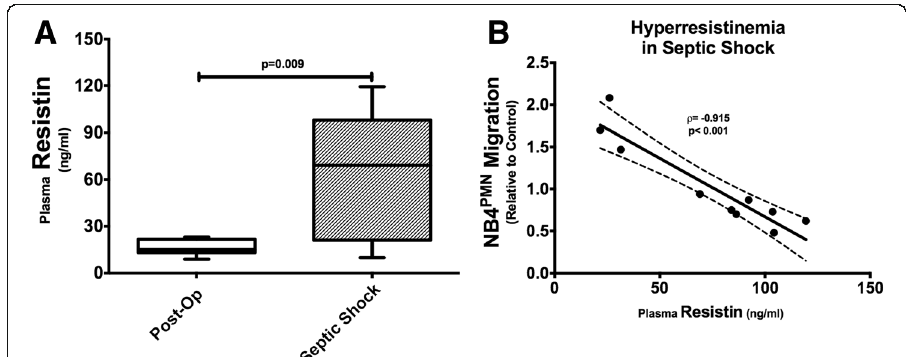
Fig. 1 a Patients with septic shock had higher plasma resistin levels compared to postoperative ICU patients without sepsis or AKI. b There is a strong correlation between hyperresistinemia and inhibition of transwell migration in NB4 PMN cells suspended in serum from patients with septic